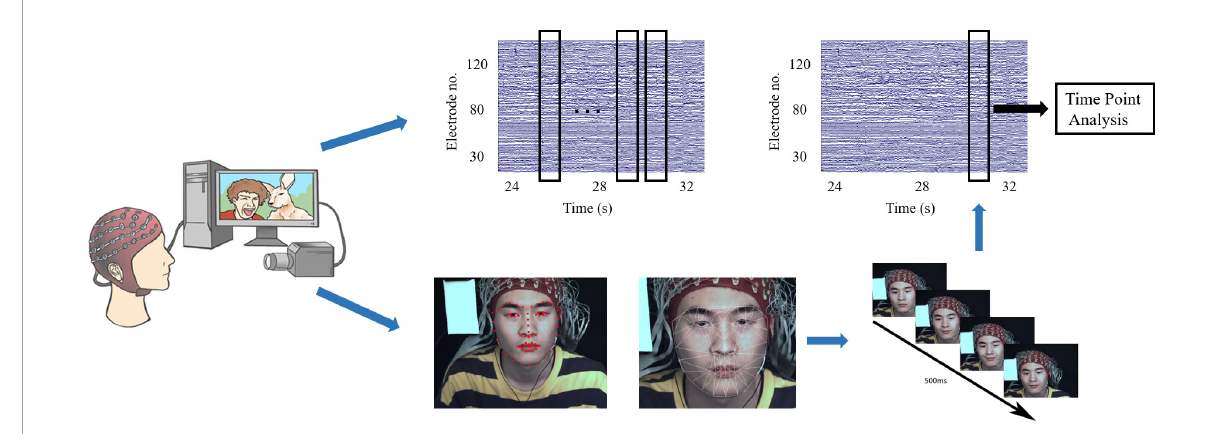
FIGURE2 Diagram of facial expression identification and determination of the time points of